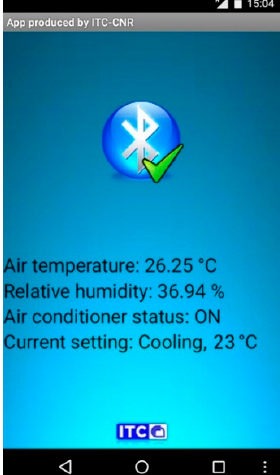
Figure 4. Application for mobile devices (Android OS).